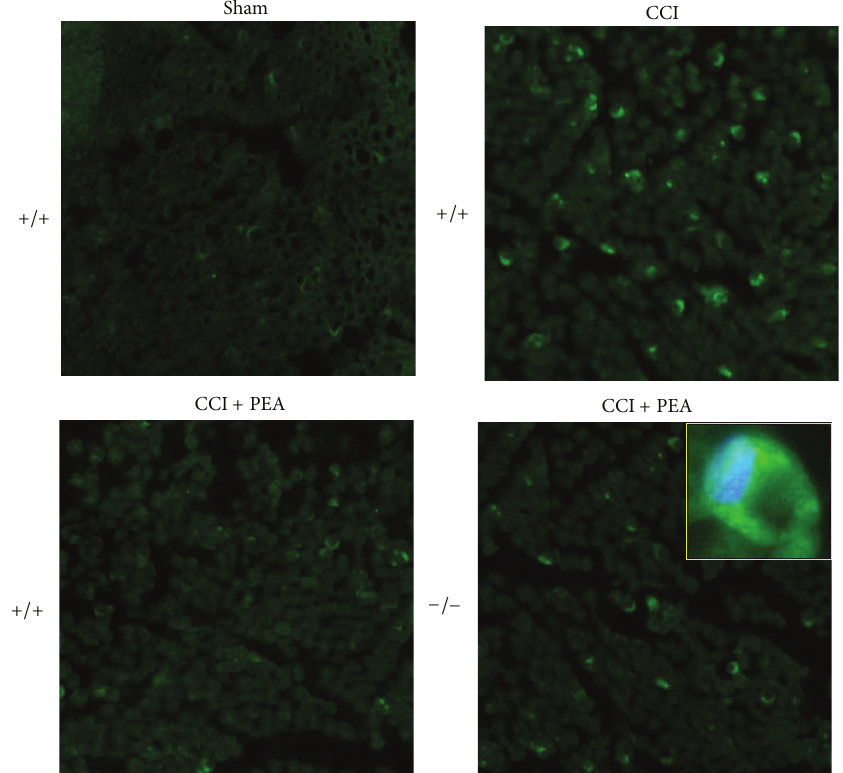
Figure 9: CD86 positive cells evaluation in sciatic nerve. 14 days after CCI, 5 𝜇 m sections of the formalin-fixed distal part of the sciatic nerve underwent immunohistochemical staining for CD86. Effect of PEA repeated treatments (30mgkg −1 s.c. daily) was evaluated in PPAR- 𝛼 +/+ and in −/− mice, and representative images are showed, and a detailed image is shown in the insert. Original magnification